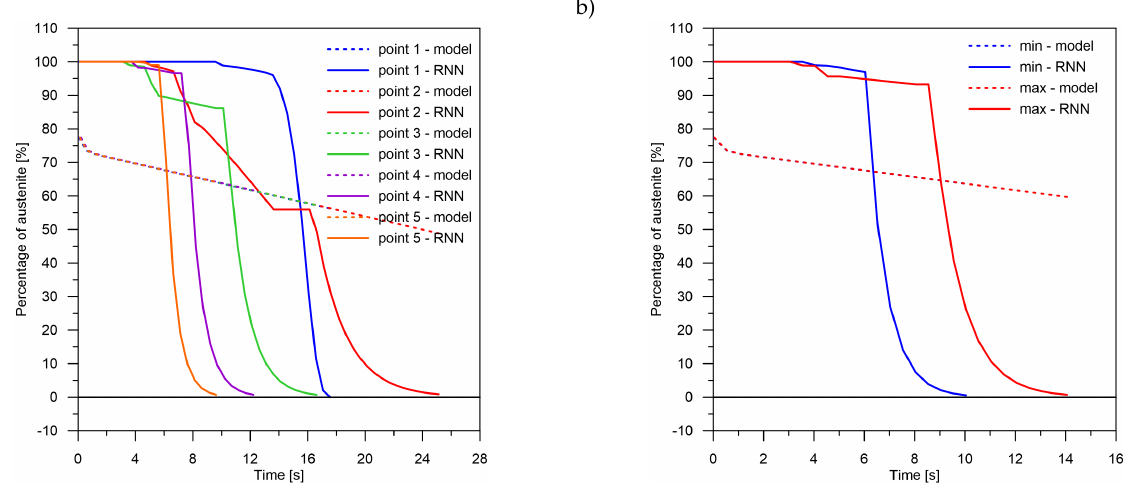
Figure 8. Kinetics of transformations: a comparison of the analytical model with the RNN model for case No. 1. ( a ) Control rates. ( b ) Rates with the largest (max—positive, min—negative)